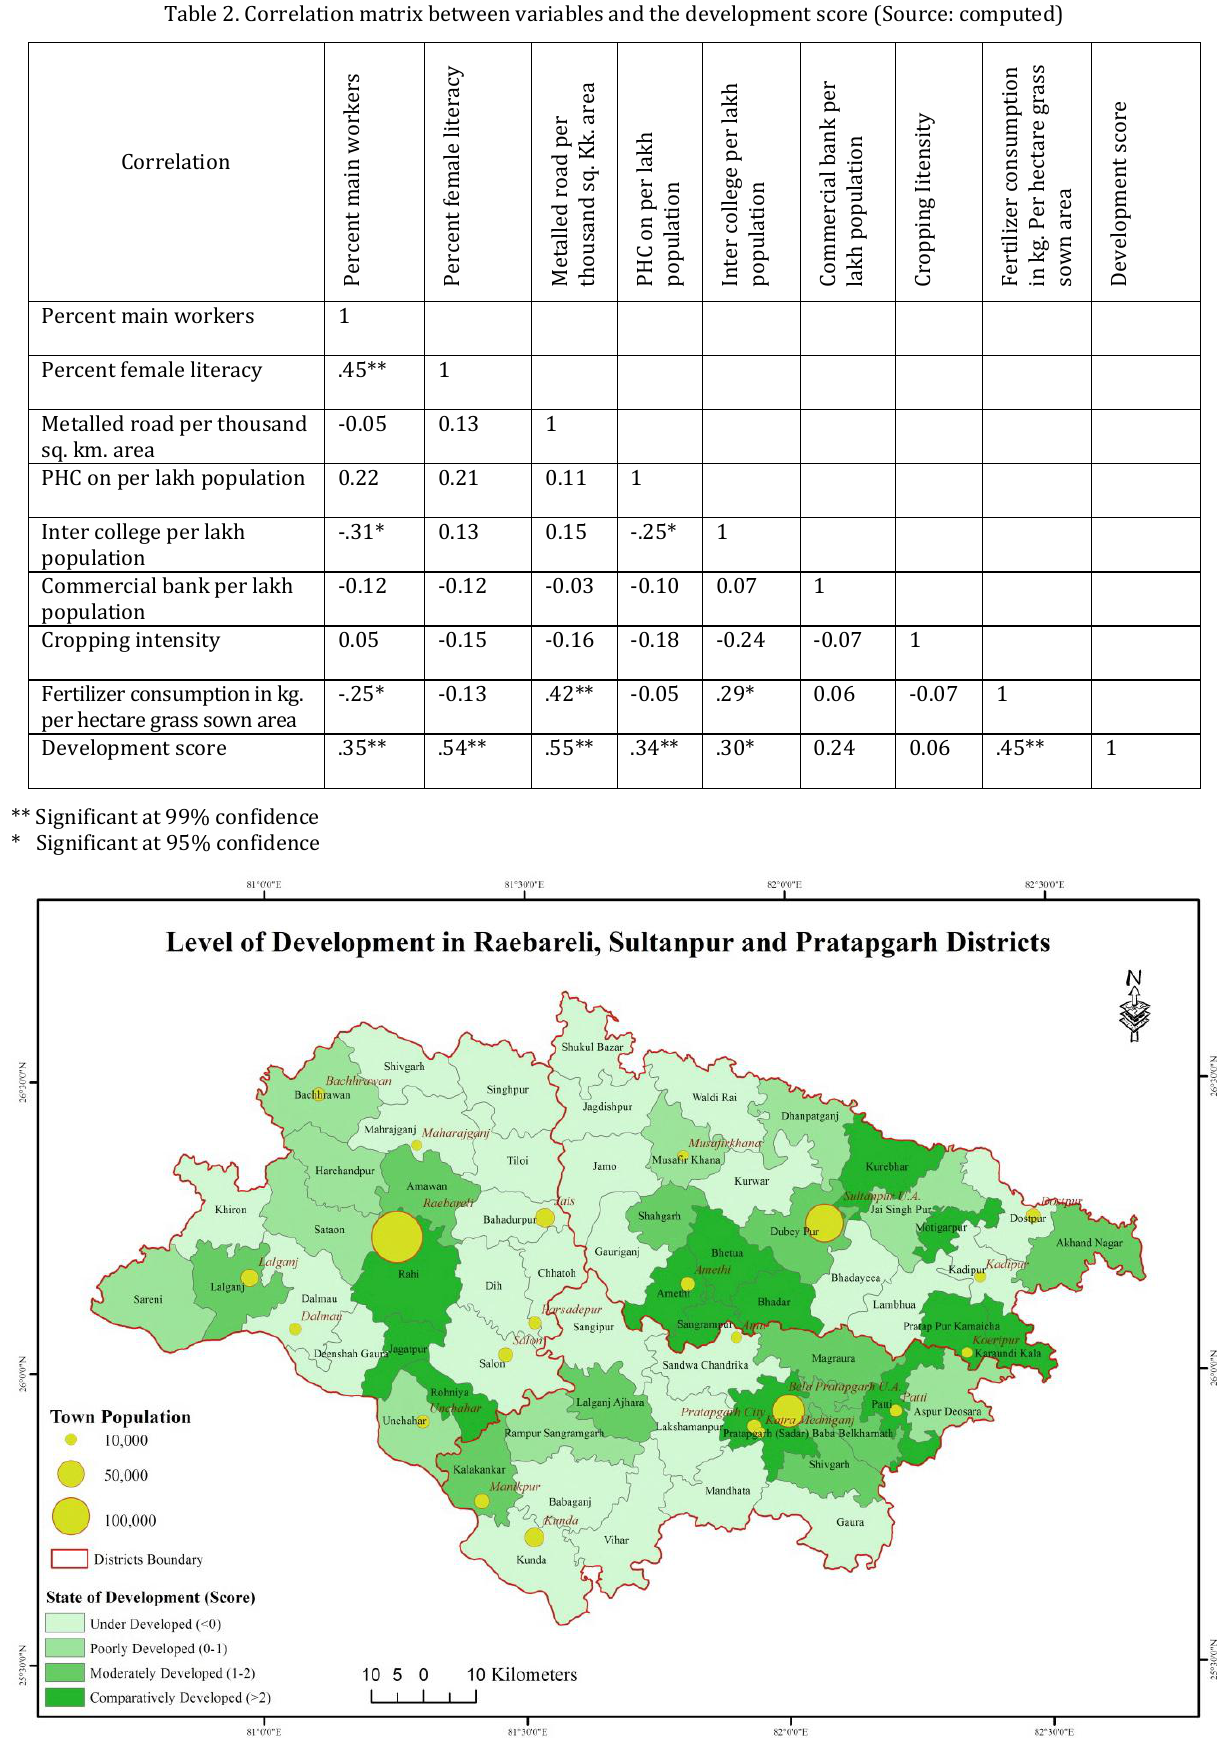
Fig. 2. State of development in the study area at the block